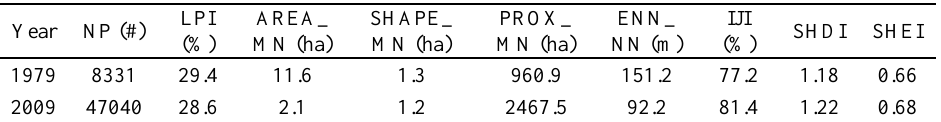
Table 6. Metrics of landscape structure for selected indices at the landscape level, 1979 and